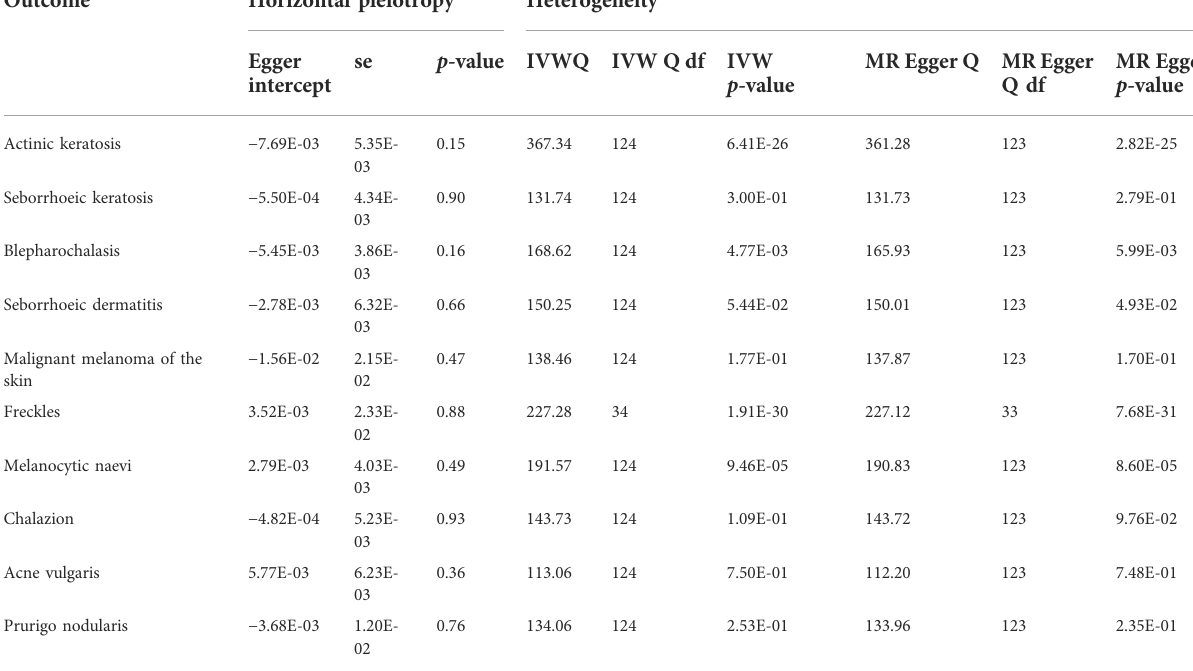
TABLE 3 The results of sensitivity analyses in the discovery MR